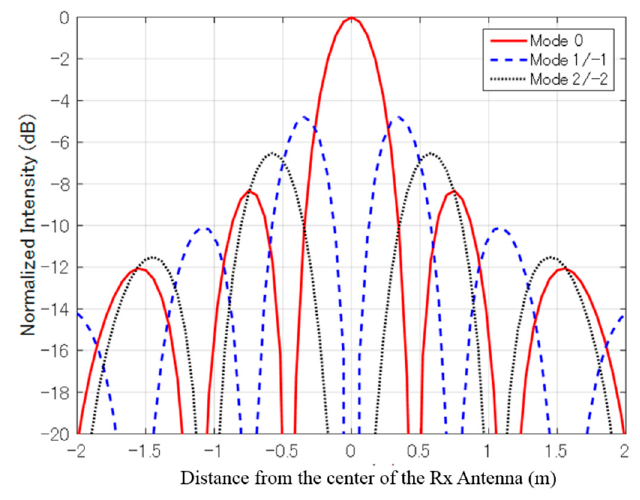
Figure 7. Bessel distributions of Rx signals.